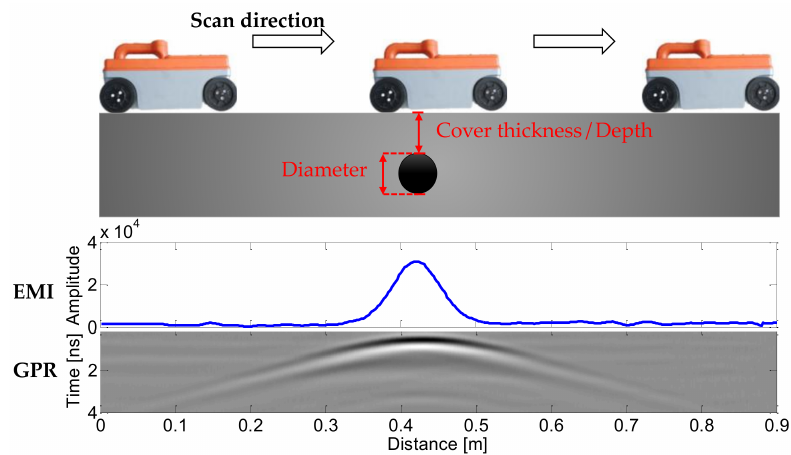
Figure 1. ( a ) Photo of the prototype of the developed rebar detection system, and ( b ) schematic structure of GPR antennas and EMI coils inside the apparatus. Figure 2. Schematic illustration of the measurement process using the developed GPR-EMI dual sensor and an example of measured EMI and GPR data.